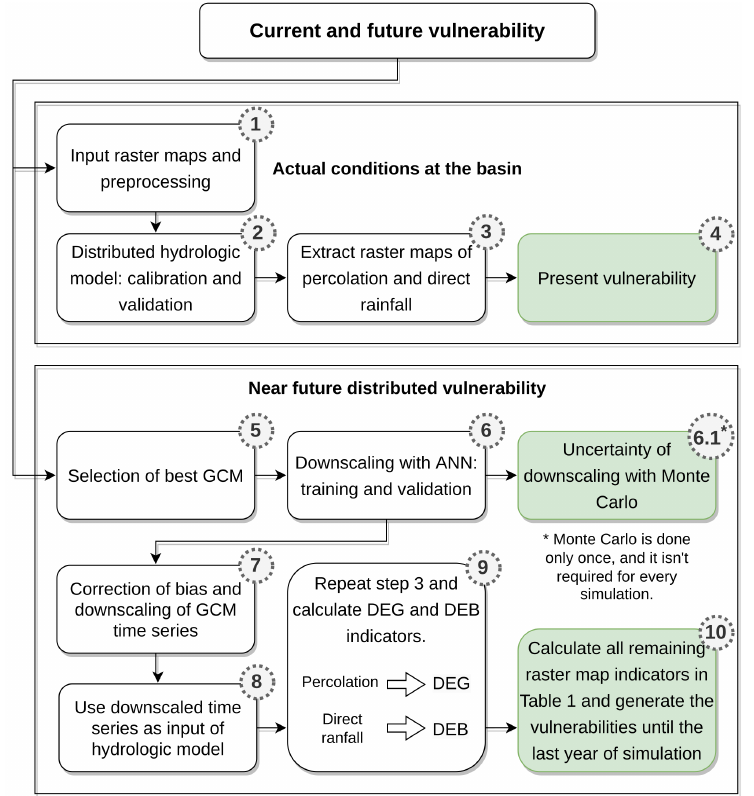
Figure 1. Conceptual scheme of the assessment of present and future vulnerabilities, executed in